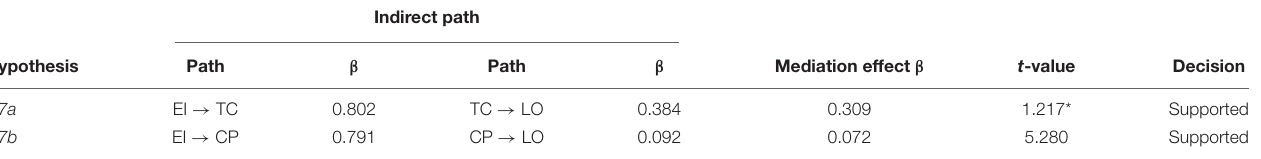
TABLE 6 | Summary of mediation results.